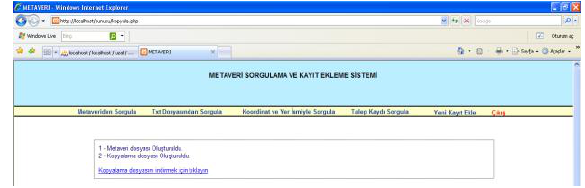
Figure 9. Record information interface of metadata